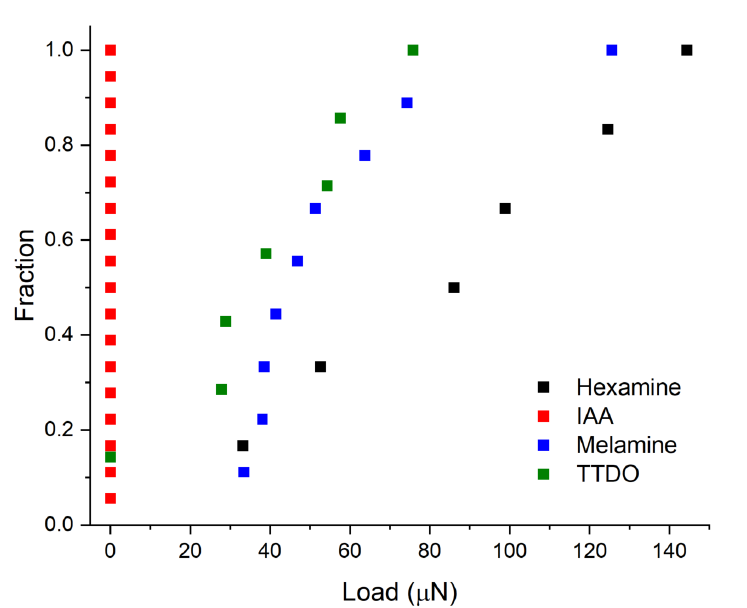
Figure 7. Cumulative distribution of load at yield for hexamine, IAA, melamine, and